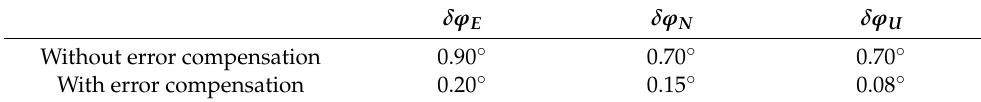
Figure 14. The comparison of attitude angle error after changing the length of the arm. Table 3. Maximum attitude angle errors (changing the length of the arm).